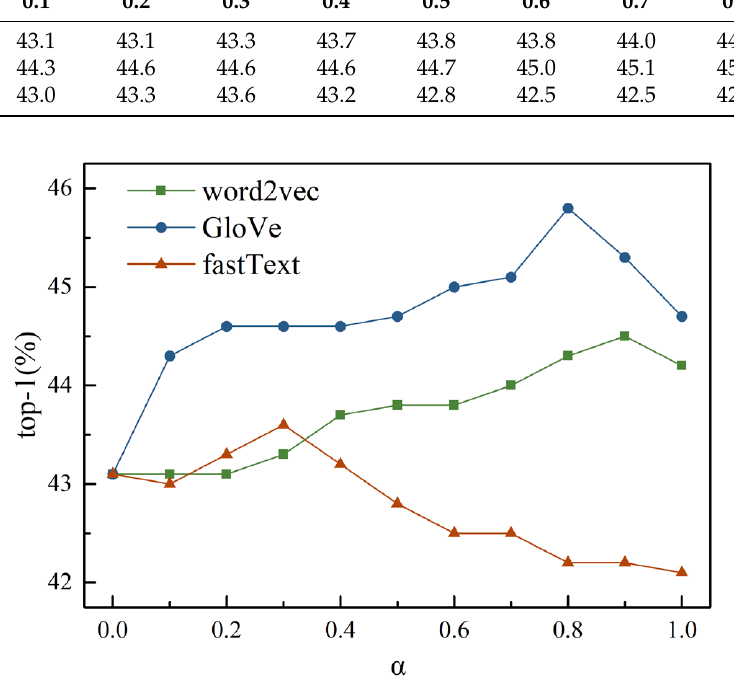
Figure 6. Changing trend of top-1 accuracy of image classification. As shown in Figure 6, the top-1 accuracy of the word vector extracted by GloVe as prior class features is significantly higher than that extracted by word2vec or fastText. As shown in Table 4, when α = 0, that is, only the attribute features are used as the prior class feature, the top-1 accuracy of image classification is 43.1%. When α = 1, that is, only word vectors are used as prior class features, the top-1 accuracies corresponding to word2vec and GloVe are 44.2% and 44.7%, respectively, which are better than the results when only attribute features are used, while the top-1 accuracy corresponding to fastText is lower than the results when only attribute features are used. For the word vectors extracted by word2vec, GloVe, and fastText, the fusions with attribute feature all have positive effects. For the word2vec word vector, when the fusion weight α = 0.8 and 0.9, the top-1 accuracy is 1.2% and 1.4% higher than that of the attribute vector only and 0.1% and 0.3% higher than that of the word vector only, respectively. For the fastText word vector, when the fusion weight α = 0.2, 0.3, and 0.4, the top-1 accuracy is 0.2%, 0.5%, and 0.1% higher than that of the attribute vector only and 1.2%, 1.5%, and 1.1% higher than that of the word vector only, respectively. For the GloVe word vector, when the fusion weight α = 0.6, 0.7, 0.8, and